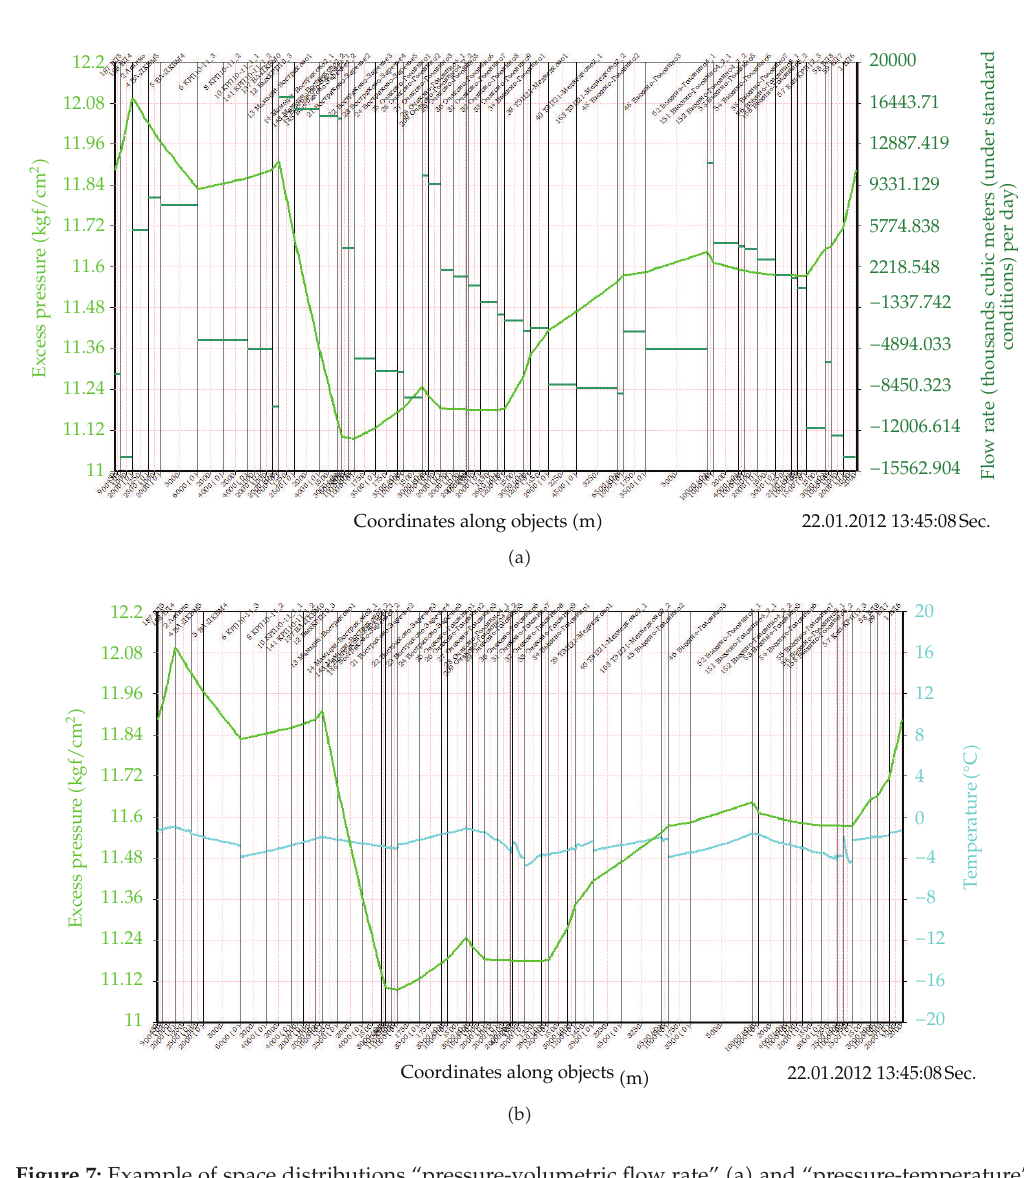
existence and multiline structure of MGR circular segment—for some segments di ff erent pipeline threads are